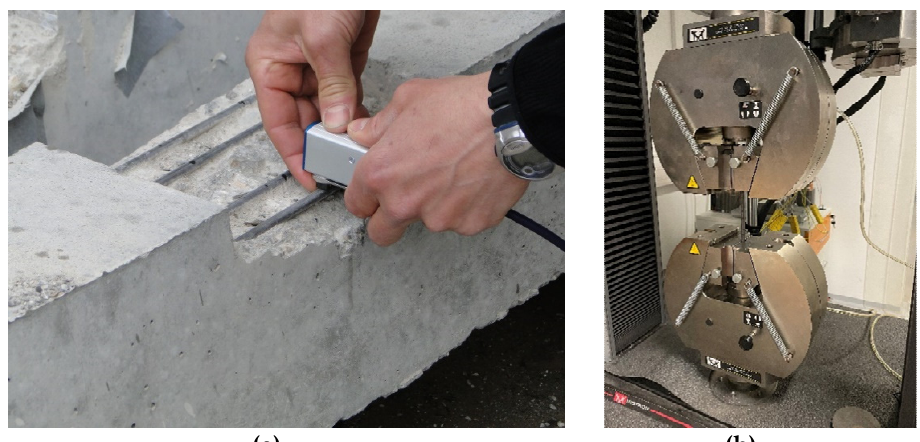
Figure 13. Magnetic Barkhausen noise measurement ( a ); calibration ( b